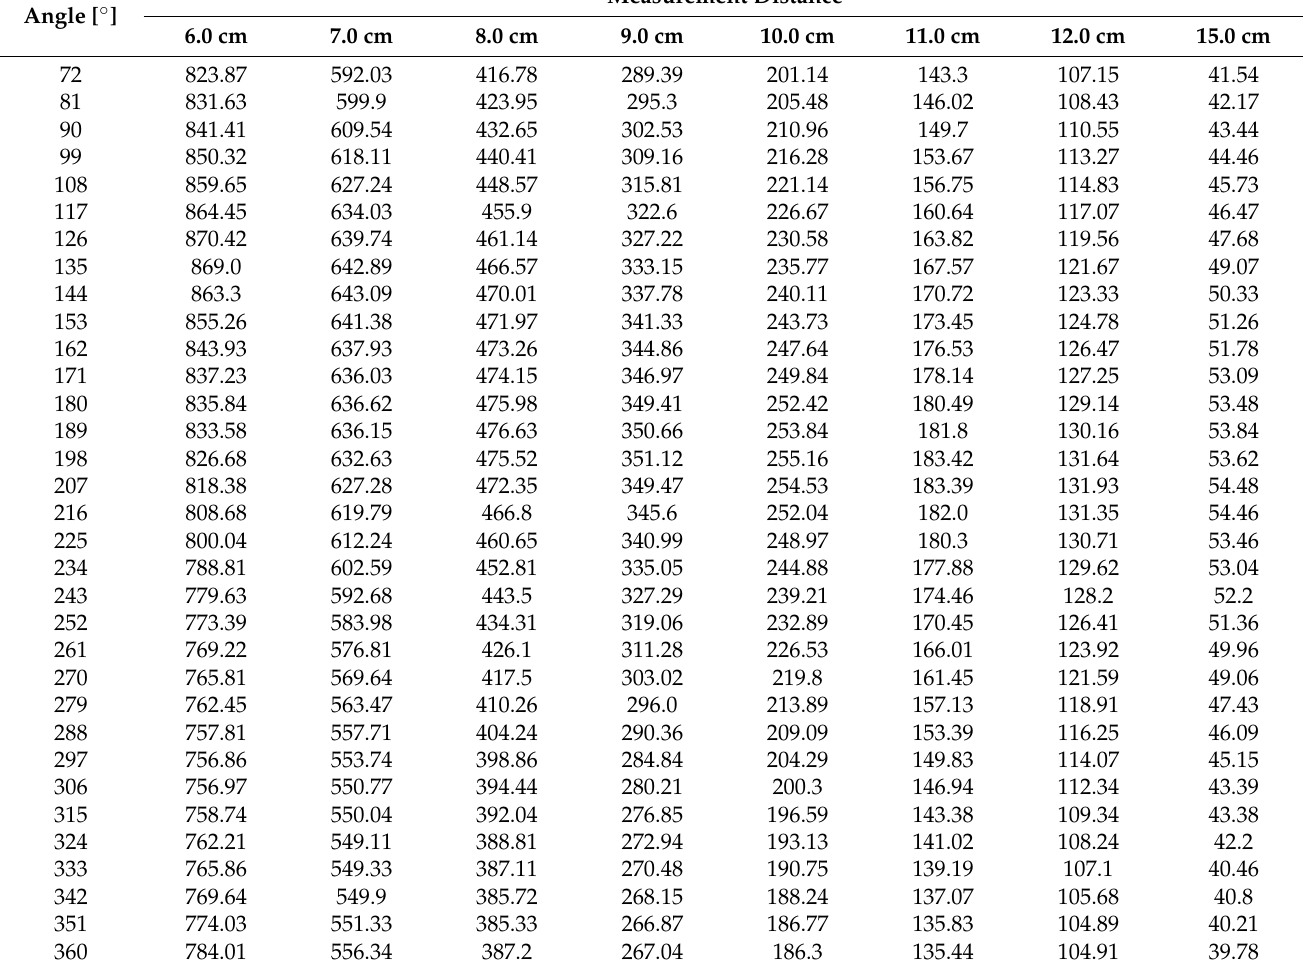
Table 6. Estimated values of the B component of magnetic induction as a function of rotation angle and measurement